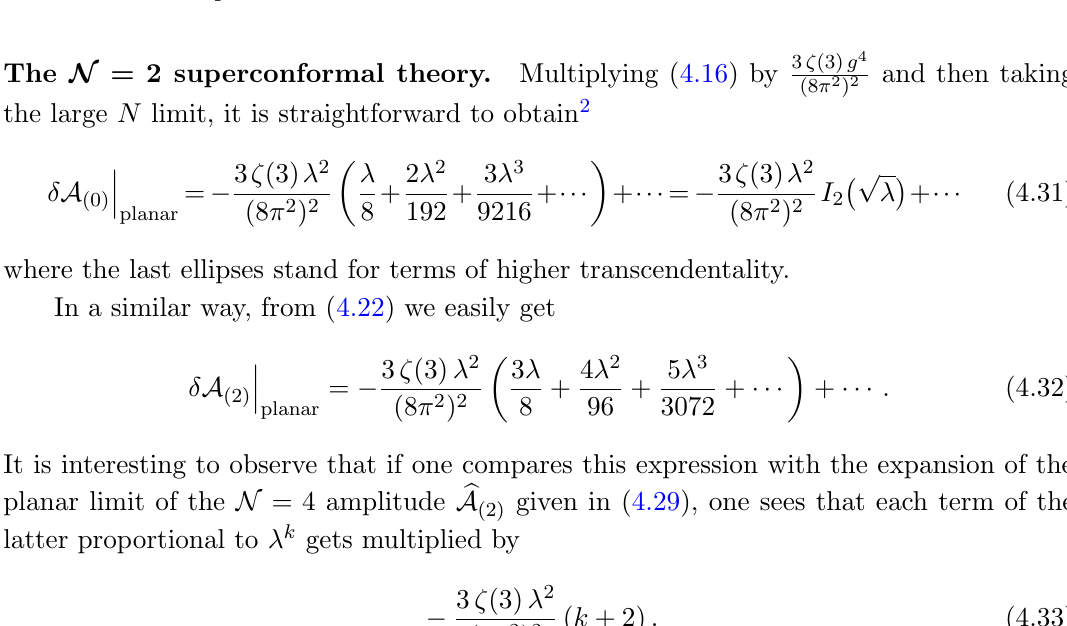
Table 4 . Results for the N = 2 superconformal matrix model in the planar limit. As before, n is the sum of the components of ~n while ‘ is their